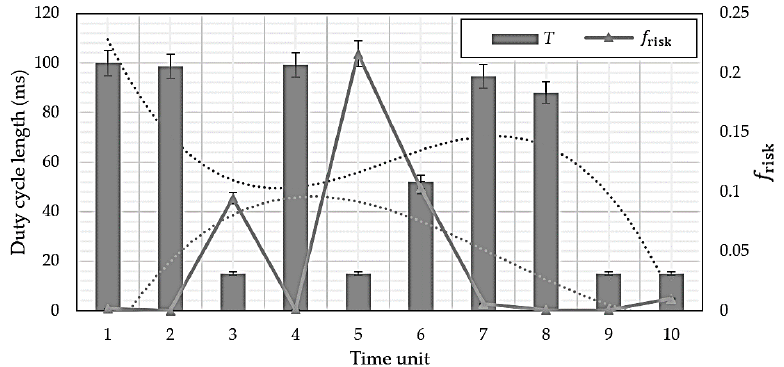
Figure 11. Change in (cid:1858) (cid:2928)(cid:2919)(cid:2929)(cid:2921) as duty-cycle length, T , changes.